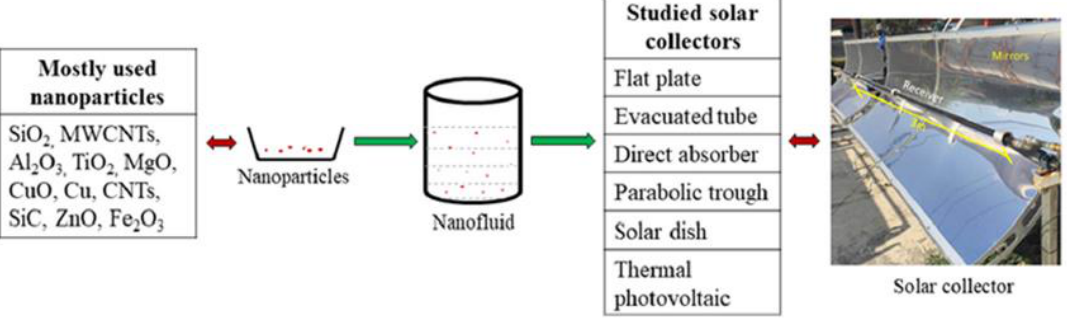
Figure 4. Application of nanofluids in solar collectors.